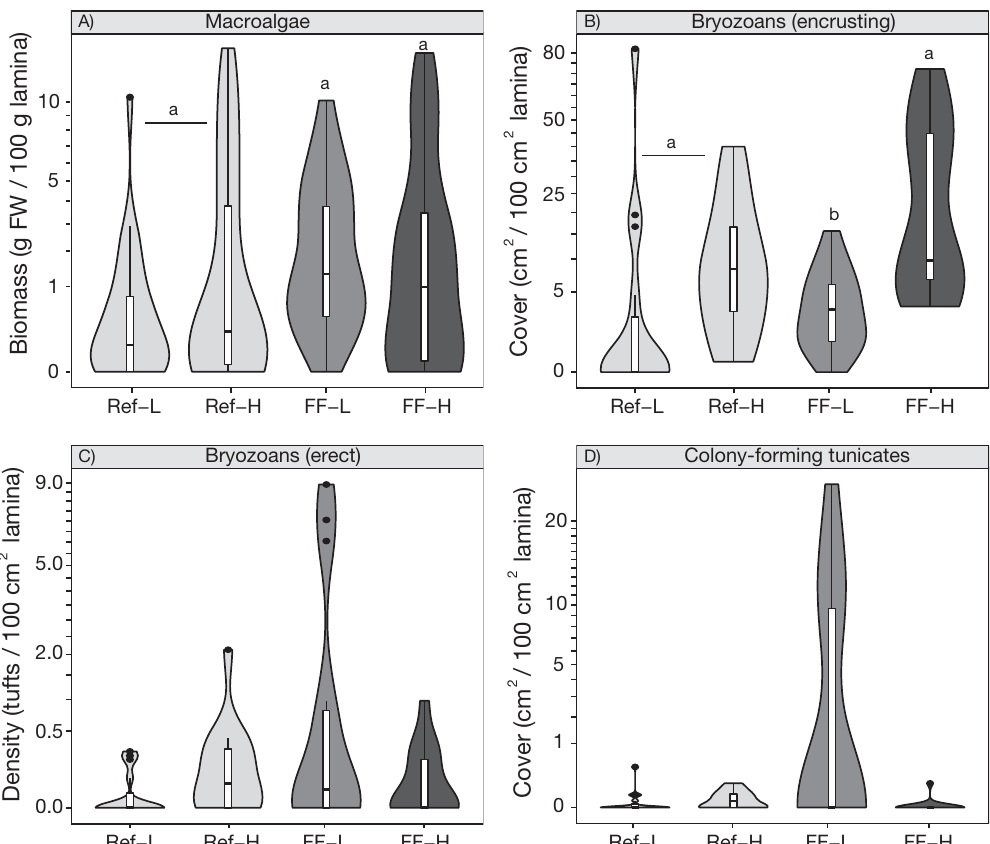
Fig. 8. Epiphytes present on Laminaria hyperborea kelp canopy laminas collected from fish farm sites (low effluent levels: FF-L; high effluent levels: FF-H) and reference sites (Ref-L, Ref-H) in the Frøya (Ref-L, FF-L) and Smøla (Ref-H, FF-H) archipelagos, Norway. (A) Algal epiphytes; (B,C) encrusting and erect bryozoans; (D) colony-forming tunicates. Note different units and use of different square-root scales on the y -axes. Different letters denote significant difference (Dunnett’s post-hoc, α = 0.05). For plot explanation, see Fig.